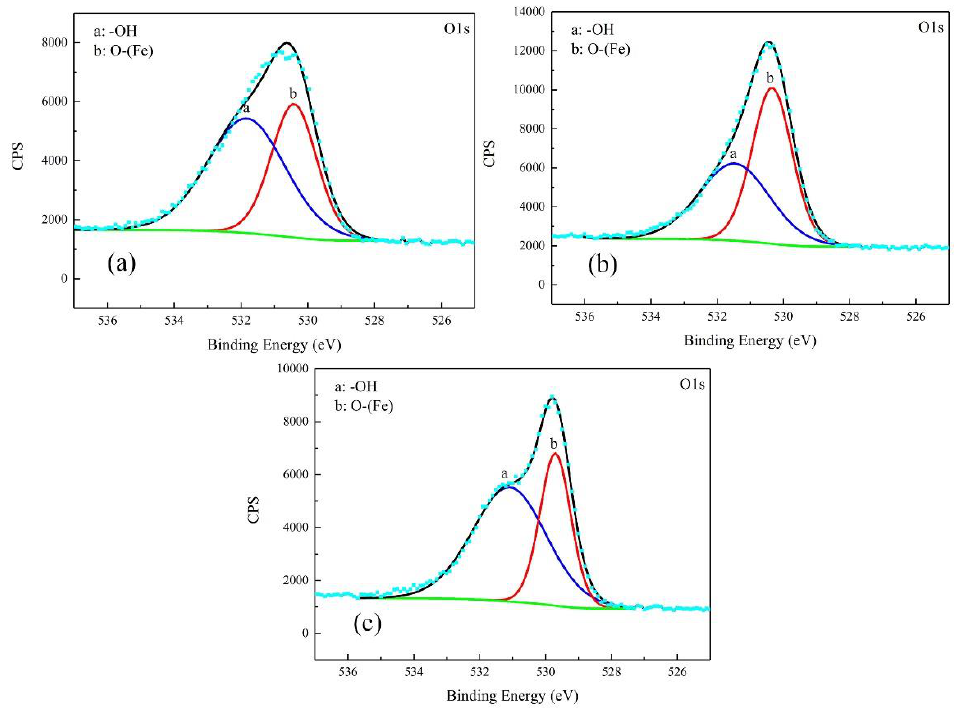
Figure 9. Detailed XPS spectra of O1s of corrosion products on the samples after galvanostatic polarization of: 0.010 A·cm −2 ( a ); 0.030 A·cm −2 ( b ); and 0.080 ( c ).